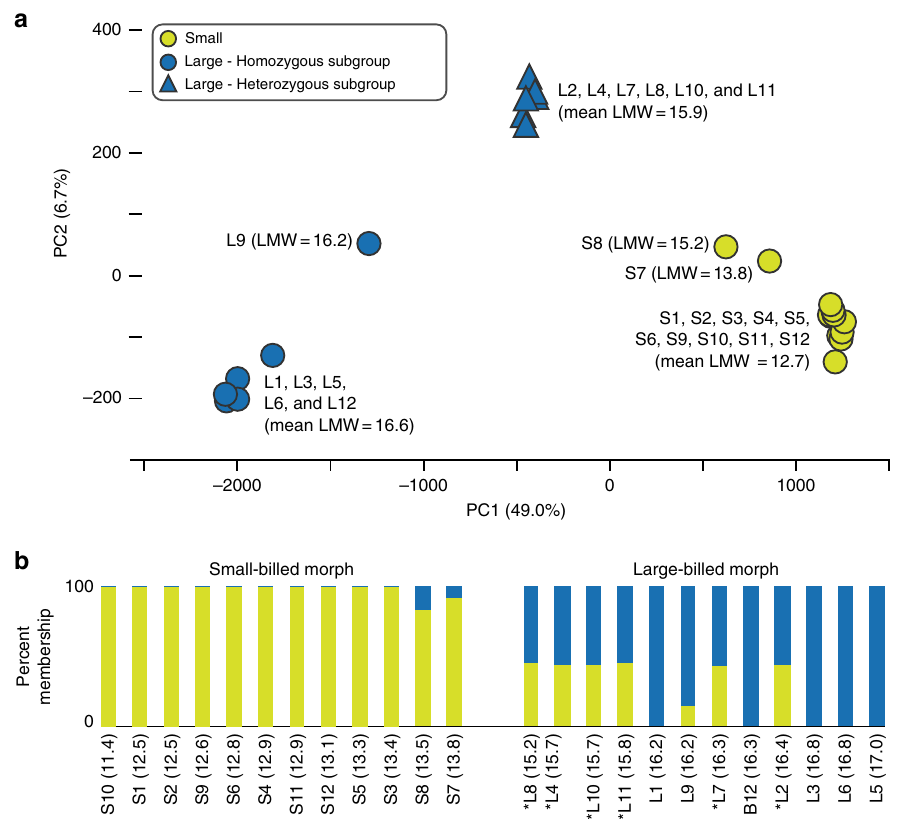
Fig. 3 Cluster analysis of small- and large-billed P. ostrinus . a A principal component analysis of 4717 SNP genotypes across the candidate and fl anking region, with two subgroups of the large-billed morph indicated. Lower mandible width (LMW in mm) and sample IDs are provided (see Supplementary Data 2). The proportion of variance explained by each component is provided along each axis. b Population structure analysis at K = 2 using 4717 SNPs from TGU1A (see Fig. S1 for K = 3 – 5). Sample IDs (LMW in parentheses) are along the X -axis, with birds ordered from smallest LMW (left) to largest LMW (right, in millimeters). The cross-validation value for K = 2 is cv = 0.462. Asterisks indicate that large-billed individuals are members of